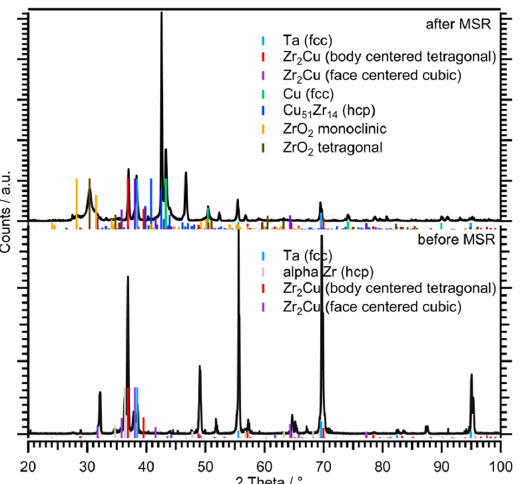
Figure 12. XRD analysis of the Cu ‐ Zr sample with a nominal Cu:Zr = 1:2 stoichiometry: before MSR ( lower panel ); and after MSR ( upper panel ).